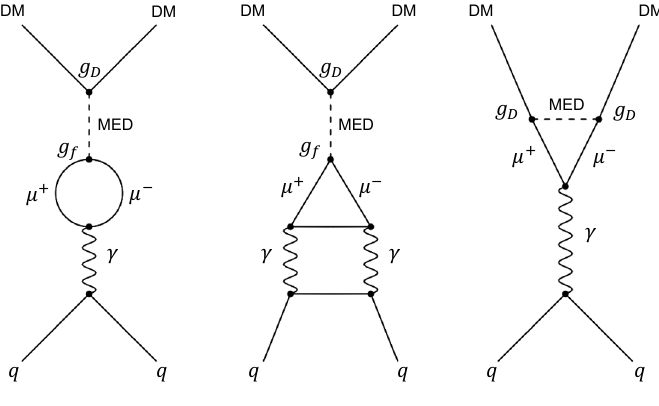
Figure 6 . The Feynman diagram for the loop-induced DM-quark scattering. The one loop contribu- tion for the Z -even mediator scenario is presented in the left panel while the two loop contribution 2 is given in the middle one. For the Z -odd mediator scenario, we draw the one loop contribution 2 in the right